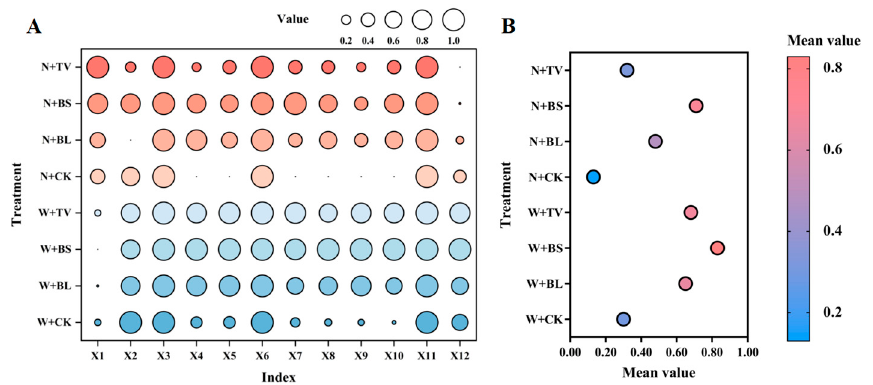
Figure 13. Comprehensive evaluation in the treatments. ( A ) Value of the membership function; ( B ) Mean value of the membership function. X1: pH; X2: EC value; X3: E4/E6 value; X4: Total N; X5: Alkali-hydrolyzable N; X6: Organic carbon; X7: Total P; X8: Available P; X9: Total K; X10: Available K; X11: C/N; X12: GI.